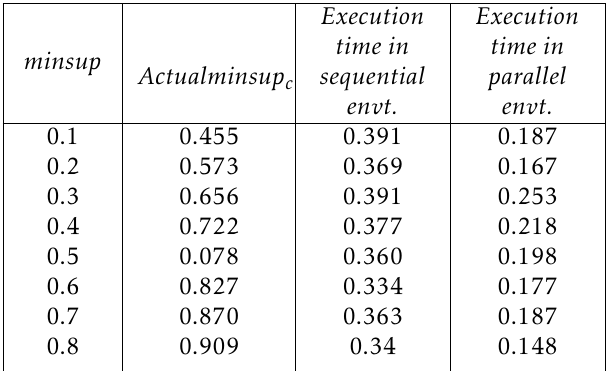
Table 13. Execution time (in milliseconds ) to find frequent singleton edges for graph stream data using proposed static approach with actual minimum support through cubic strategy in sequential and parallel environment